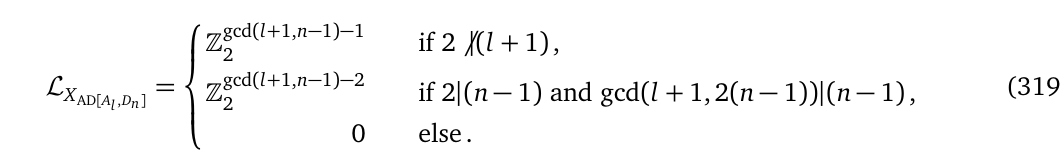
Table 4: Defect groups for the AD [ A